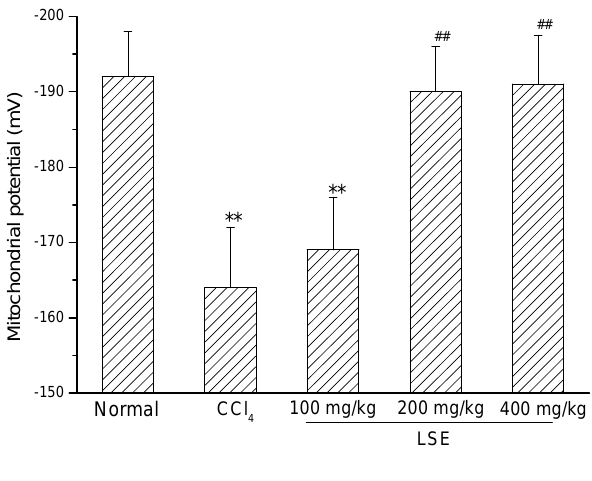
Figure 3. Prevention of LSE on mitochondrial membrane potential dissipation induced by CCl . 4 Mice were divided into 5 groups as Normal, CCl , 100 mg/kg LSE, 200 mg/kg LSE and 400 mg/kg 4 LSE. Livers from each group of mice were taken 18 h later. Liver mitochondria were isolated and the mitochondrial membrane potential was determined using rhodamine 123. Each value represents mean group. ± S.D. of 8 mice. **P<0.01, vs. Normal, ## P<0.01, vs. CCl 4